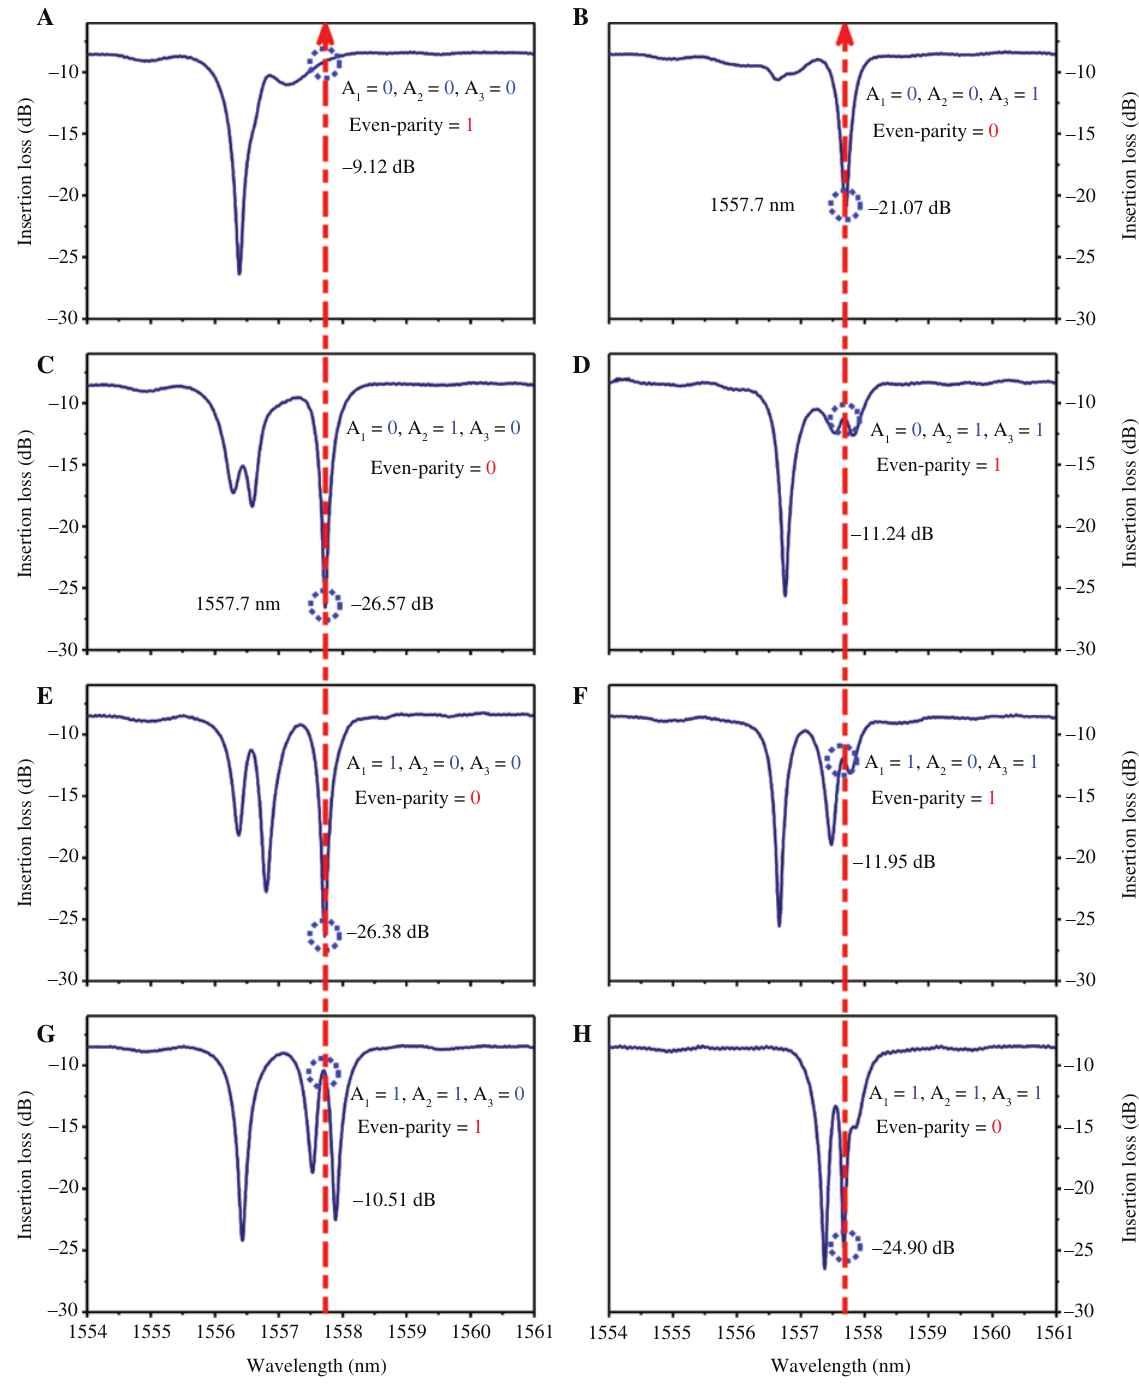
Figure 6: Response spectra in the even-parity port under different combinations of voltages. In (A)–(H), logic 1 (0) of each signal represent that the corresponding voltage is at high (low) level. The high levels of voltage applied to the , MRR , and MRR are 2.82 V, 2.30 V, and 2.62 V, respectively, while the low levels are all at 0 micro-heaters above MRR 1 2 3